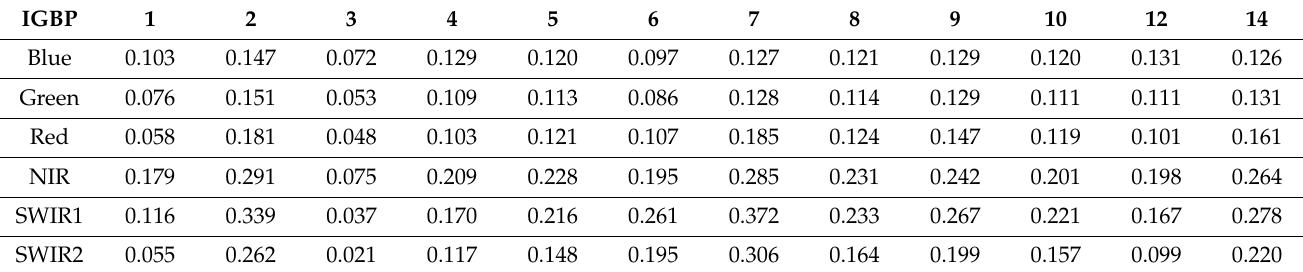
Table 3. TOA reflectance profiles for IGBP